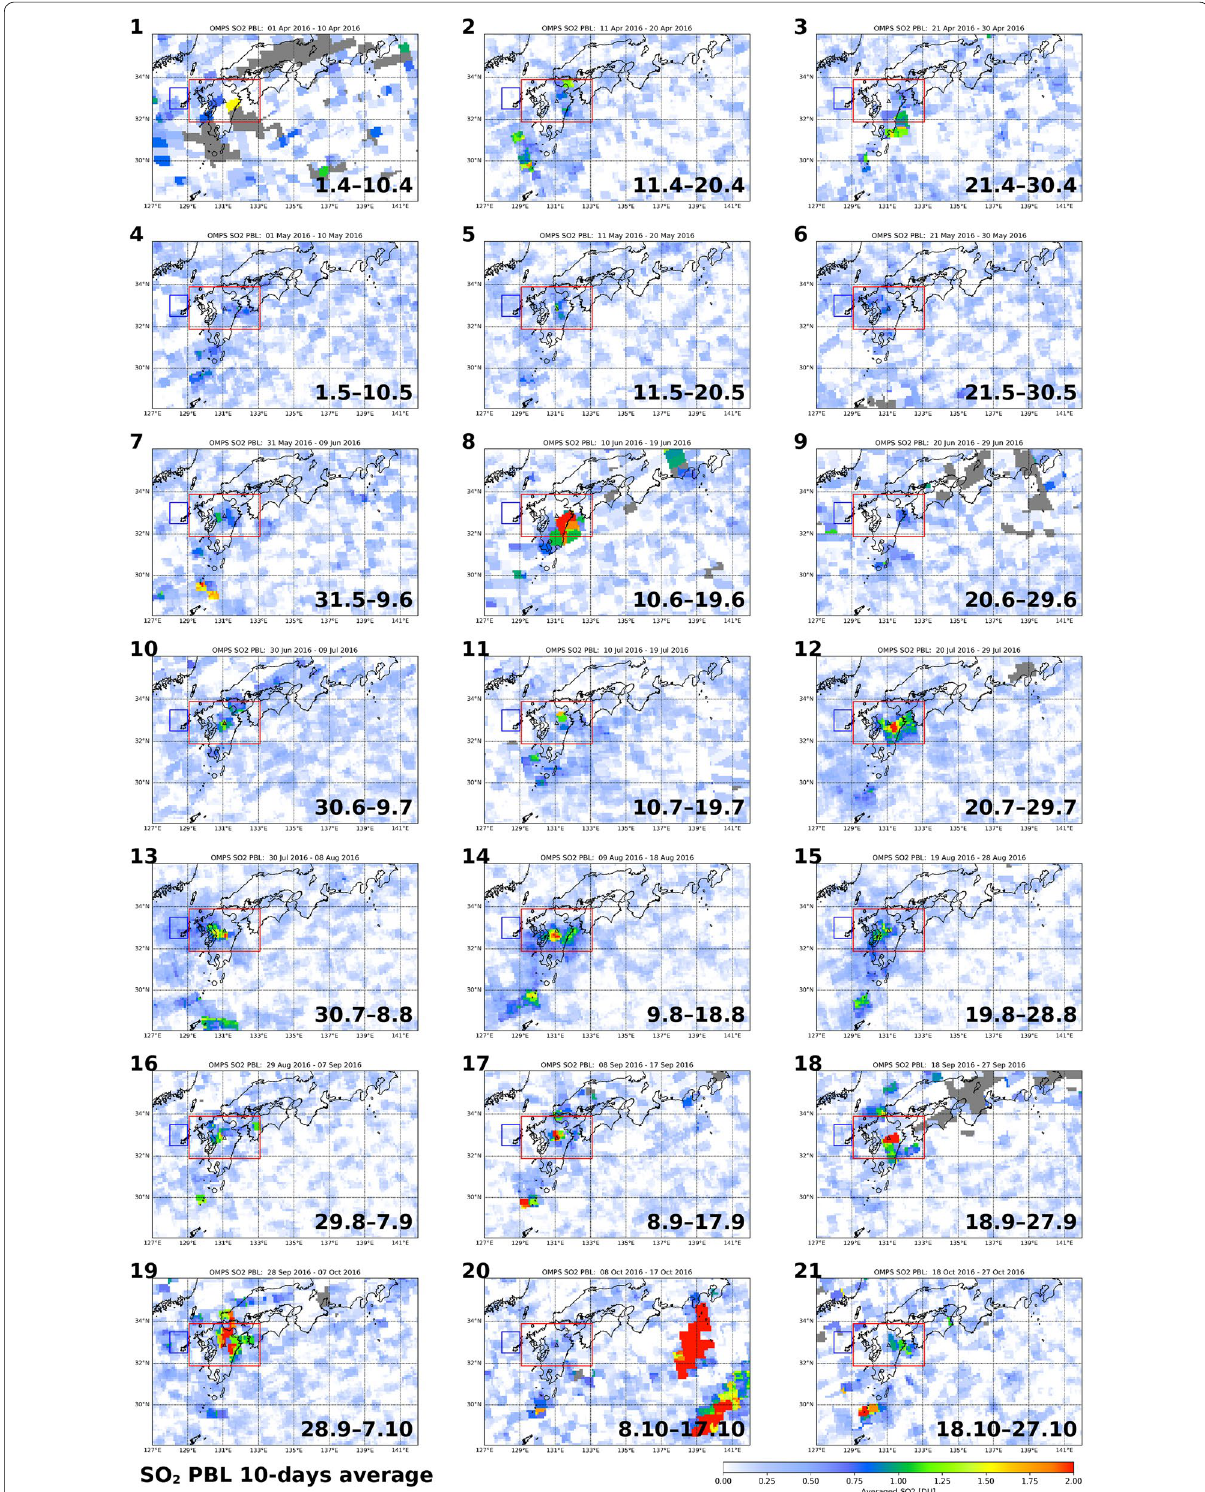
Fig. 3 Maps of the 10-day averaged SO 2 PBL VCDs measured by OMPS from 1 April to 27 October 2016. The period for each map is shown at the right bottom of the map (DD.MM–DD.MM). Location of Aso volcano is depicted with the triangle. The volcanic and SO 2 -free regions for the SO 2 mass calculation (see text) are shown with red and blue rectangles, respectively. The high SO 2 VCDs around 140°E in longitude found in 8.10– 17.10 map correspond to the SO 2 cloud by the 8 October